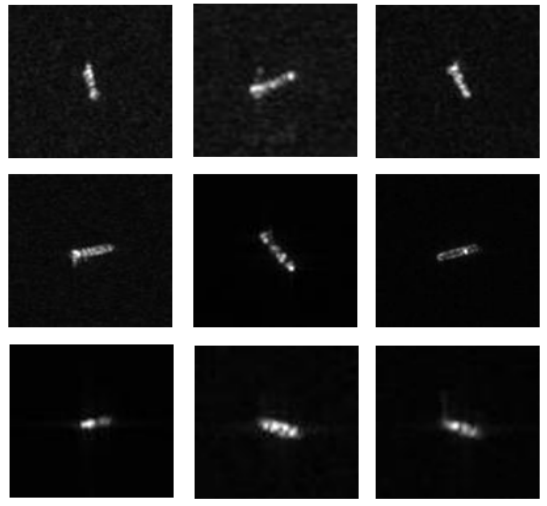
Figure 3. Example of the data set. Top to bottom : cargo ship; container ship; tanker.